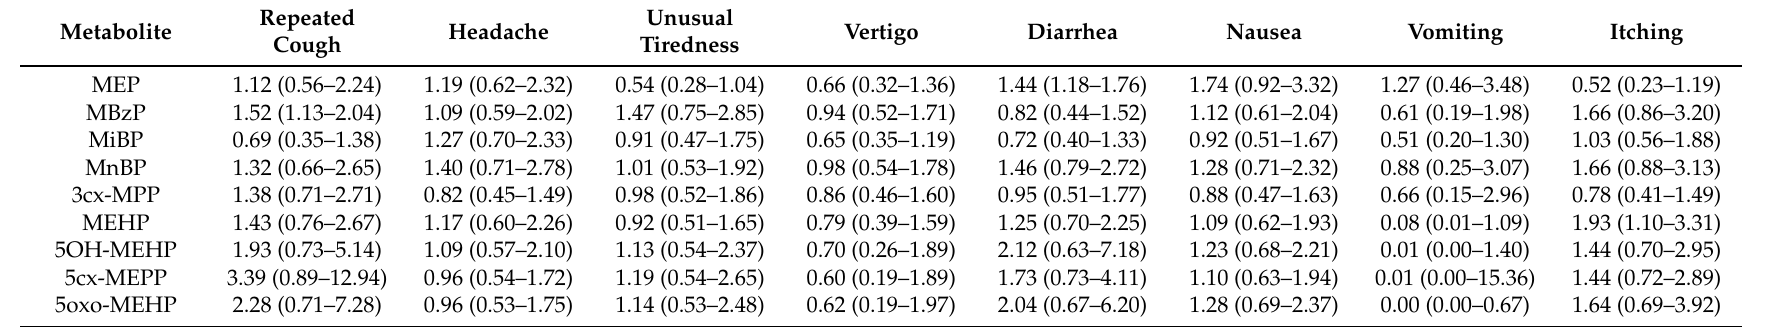
Table 5. Results of logistic regression of symptoms during the last 3 months in mothers on phthalate metabolites. Odds ratios and 95% confidence intervals for an increase of one standard deviation of the